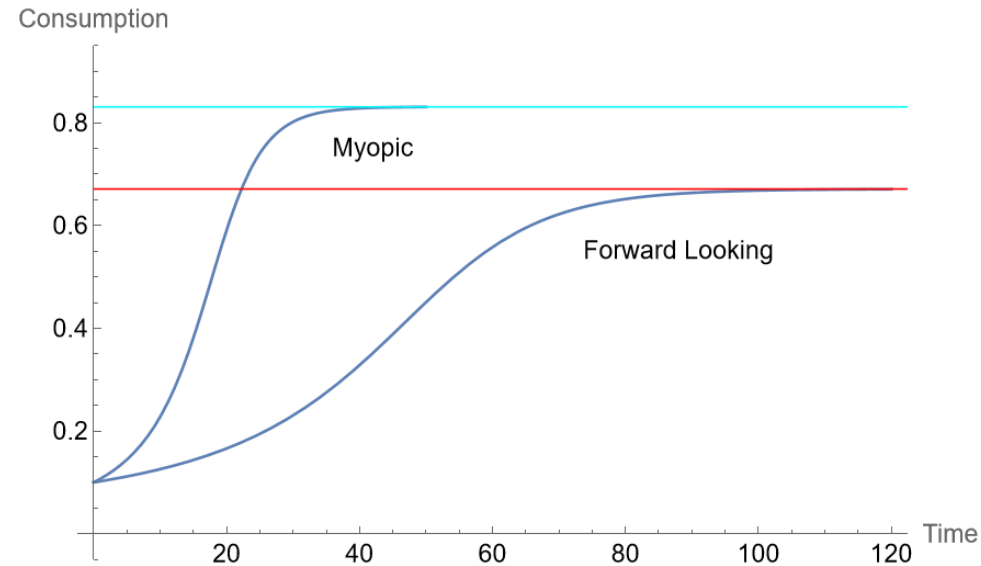
Figure 2. Heterogeneity analysis: paths to the steady states for a myopic (small σ ) and a forward- looking (large σ )